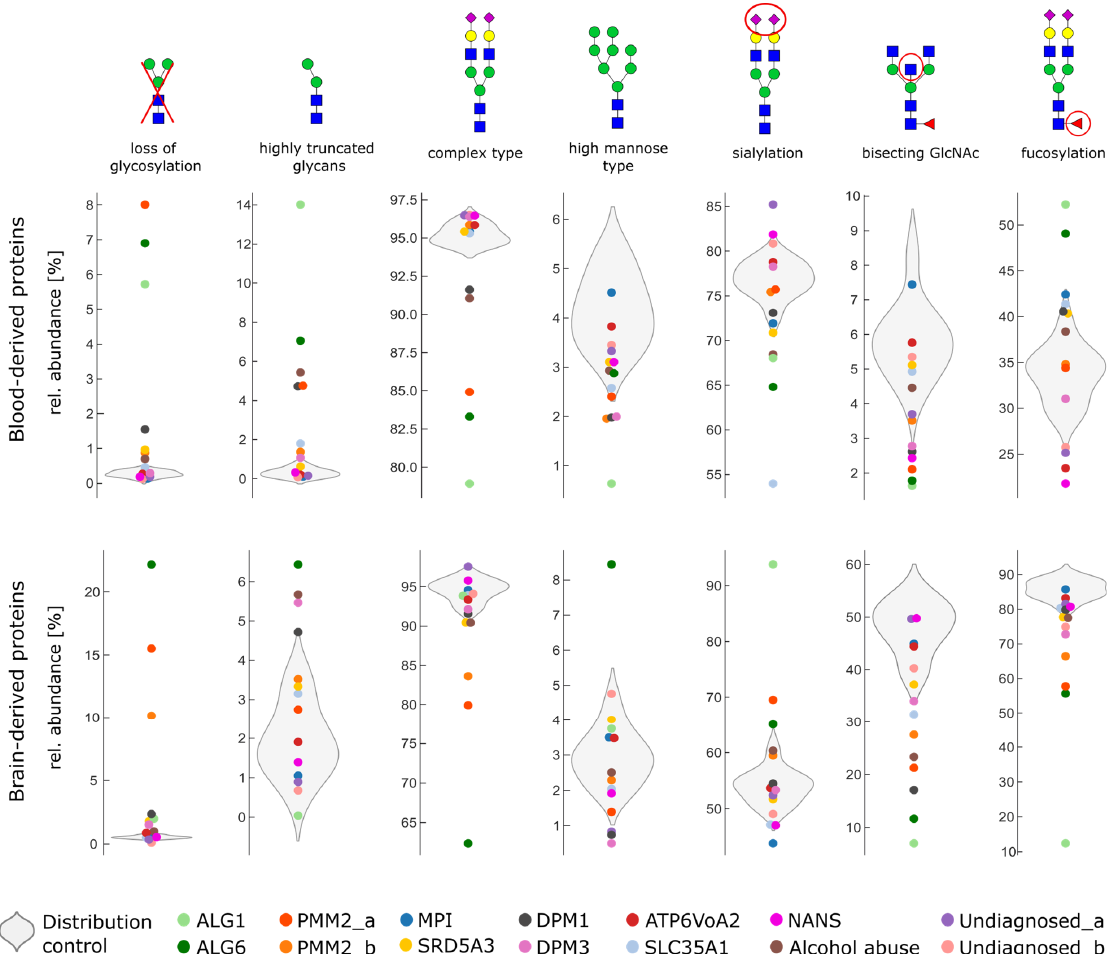
Figure 5. Glycan class variability of CDG patients, two patients without diagnoses, and one patient diagnosed with alcohol abuse compared to the glycan distribution in controls (grey violin). Severe changes in glycosylation are observed in the patients diagnosed with ALG1-CDG and ALG6-CDG, as well as both PMM2-CDG patients. Here, the complete loss of glycosylation is more pronounced on brain-derived proteins. As expected, the patient diagnosed with alcohol abuse shows a higher level of truncated glycans on blood-derived proteins compared to brain-derived proteins. The patient diagnosed with SLC35A1 (the impairment of CMP-sialic acid transporter) shows lower levels of sialylation for blood-derived proteins and almost normal levels for brain-derived proteins, potentially due to lower levels of sialylation seen on brain-type